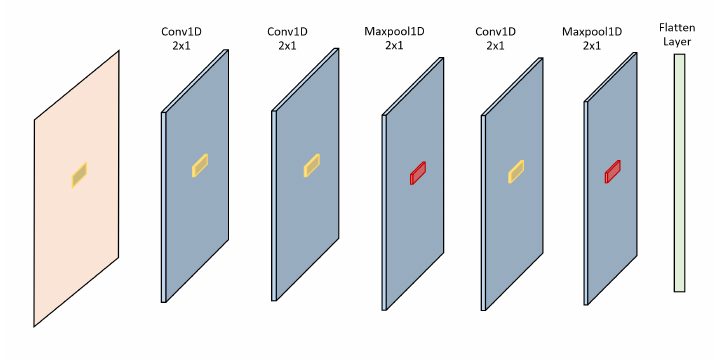
Figure 6. Convolution and maxpool layers for multichannel